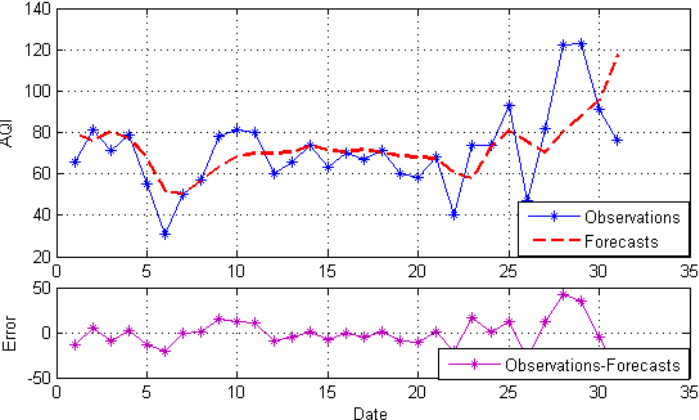
Figure 4. The forecasts and error based on